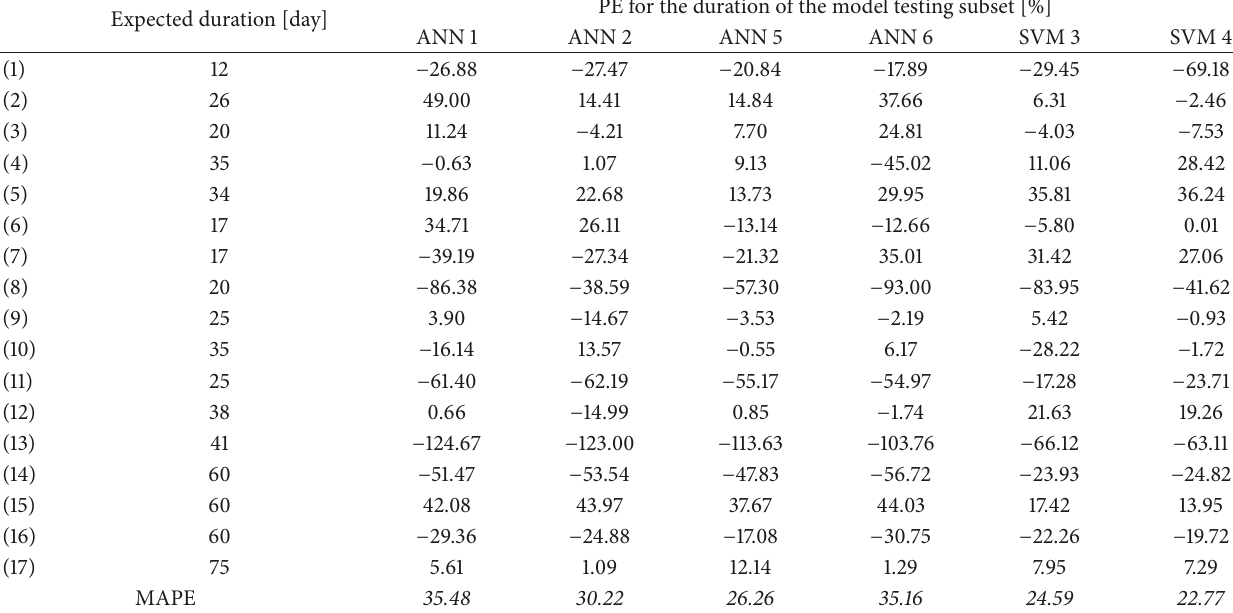
Table 12: PE for estimation of duration, testing